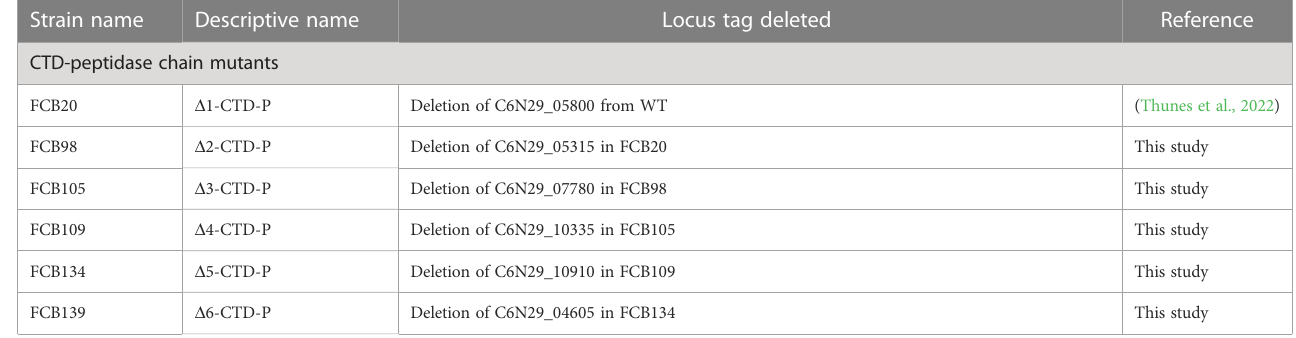
TABLE 1 Peptidase mutants used in this study a